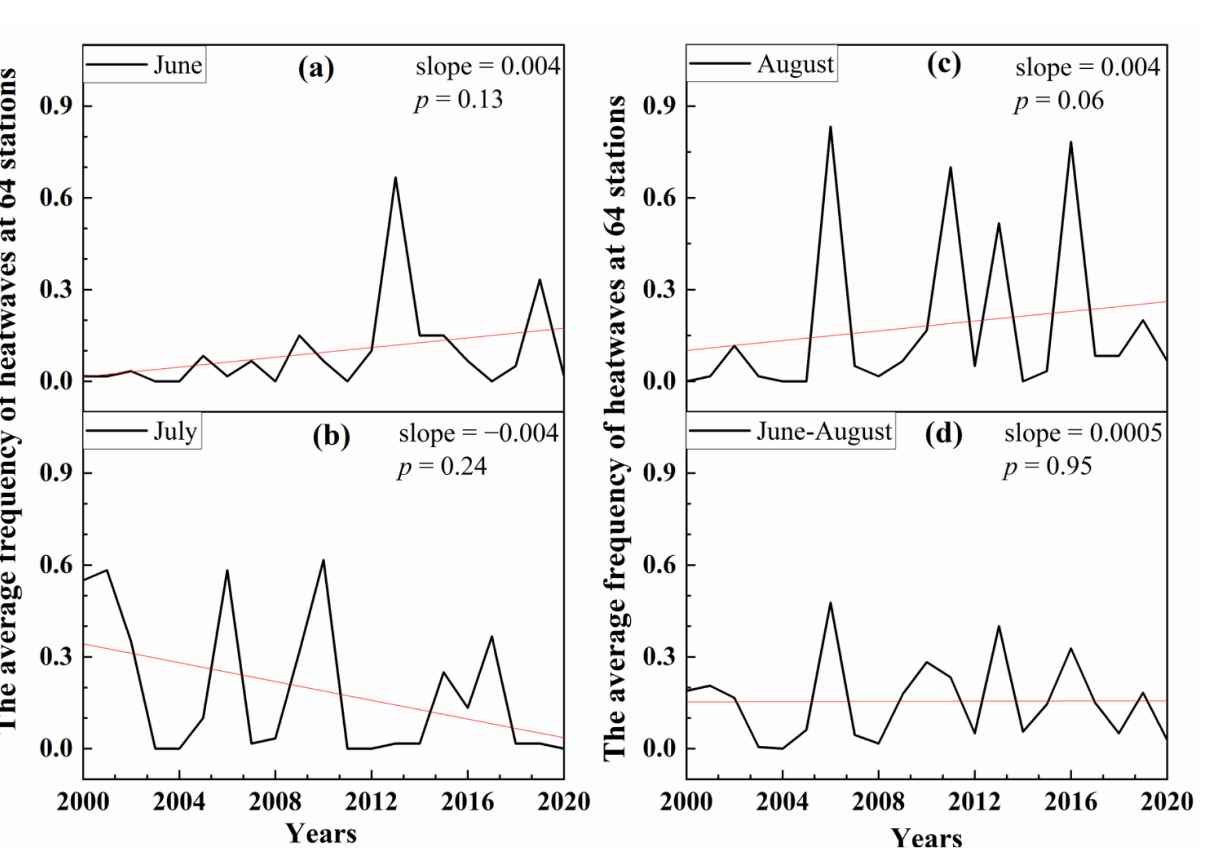
Figure 2. The average frequency of heatwaves at 64 stations in June ( a ), July ( b ), and August ( c ), and June − August ( d ) on the Tibetan Plateau from 2000 to